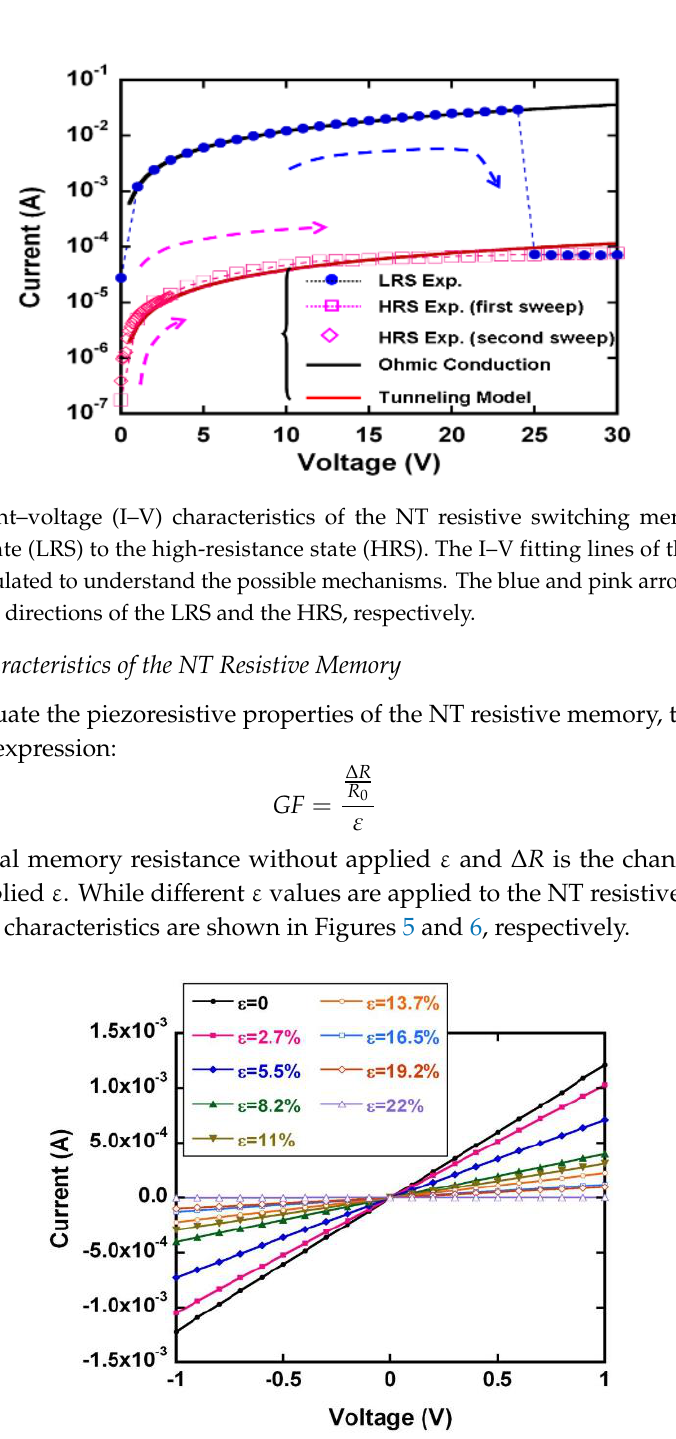
Figure 3. A real setup picture of electrical and mechanical stretching measurements. 3. Results and Discussion 3.1. WORM Characteristics Figure 4 shows the current – voltage (I – V) characteristics of the non-volatile NT resistive memory. By sweeping voltage from 0 to 30 V at a speed of approximately 1.88 V/s, the NT resistive memory was switched from the low-resistance state (LRS) to the high-resistance state (HRS). The switching behavior is called the writing process. Although the applied voltage was swept again from 0 to 30 V (first voltage sweep), the NT resistive memory remained in the HRS and demonstrated to have typical WORM characteristics, further suggesting the permanent HRS caused by the current-induced